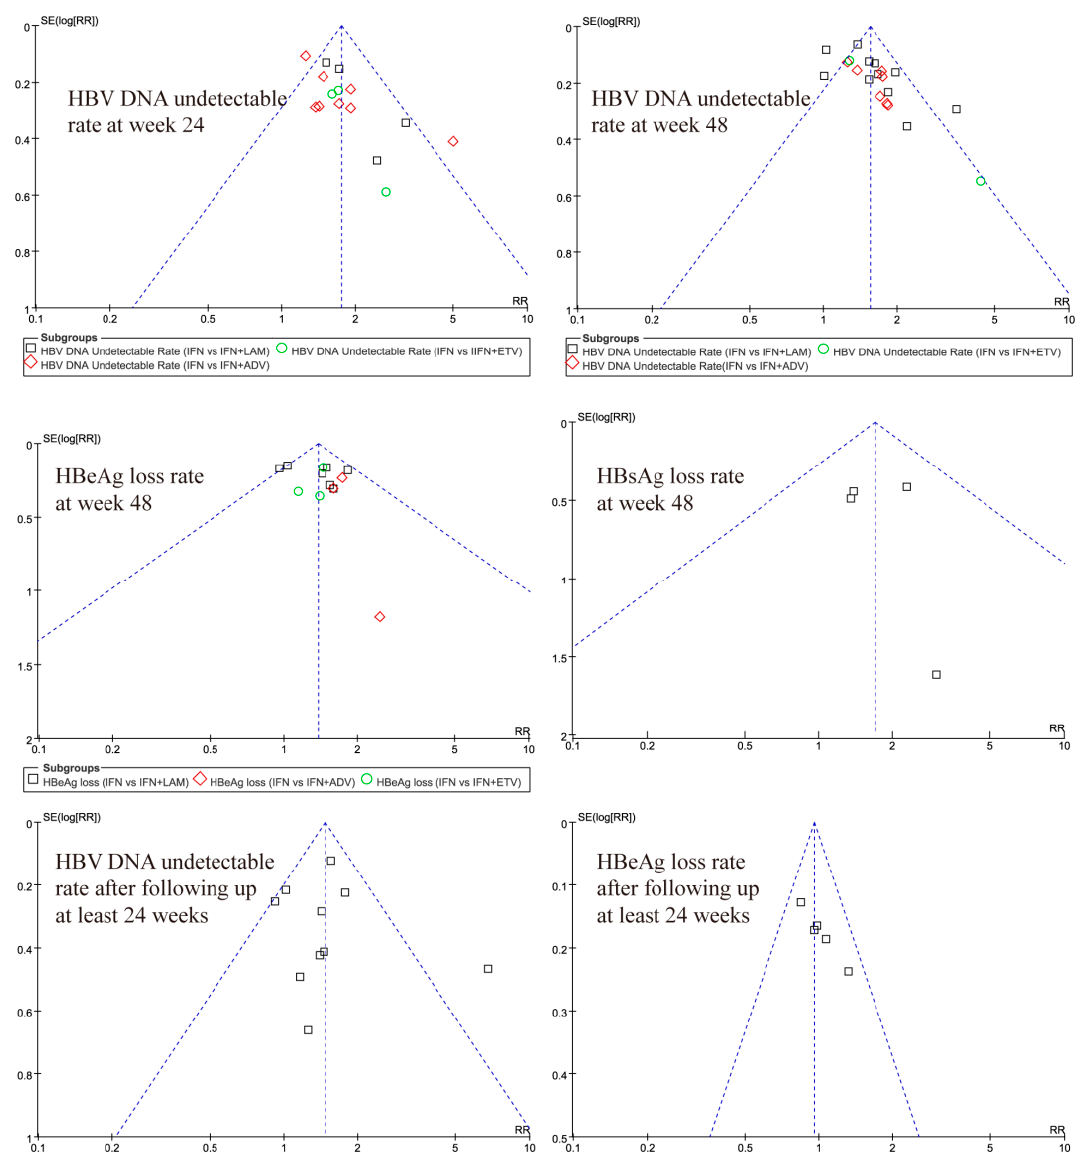
Figure 5. Funnel plots for relative risks of IFN and IFN plus NAs in virological and serological responses at different treatment periods.